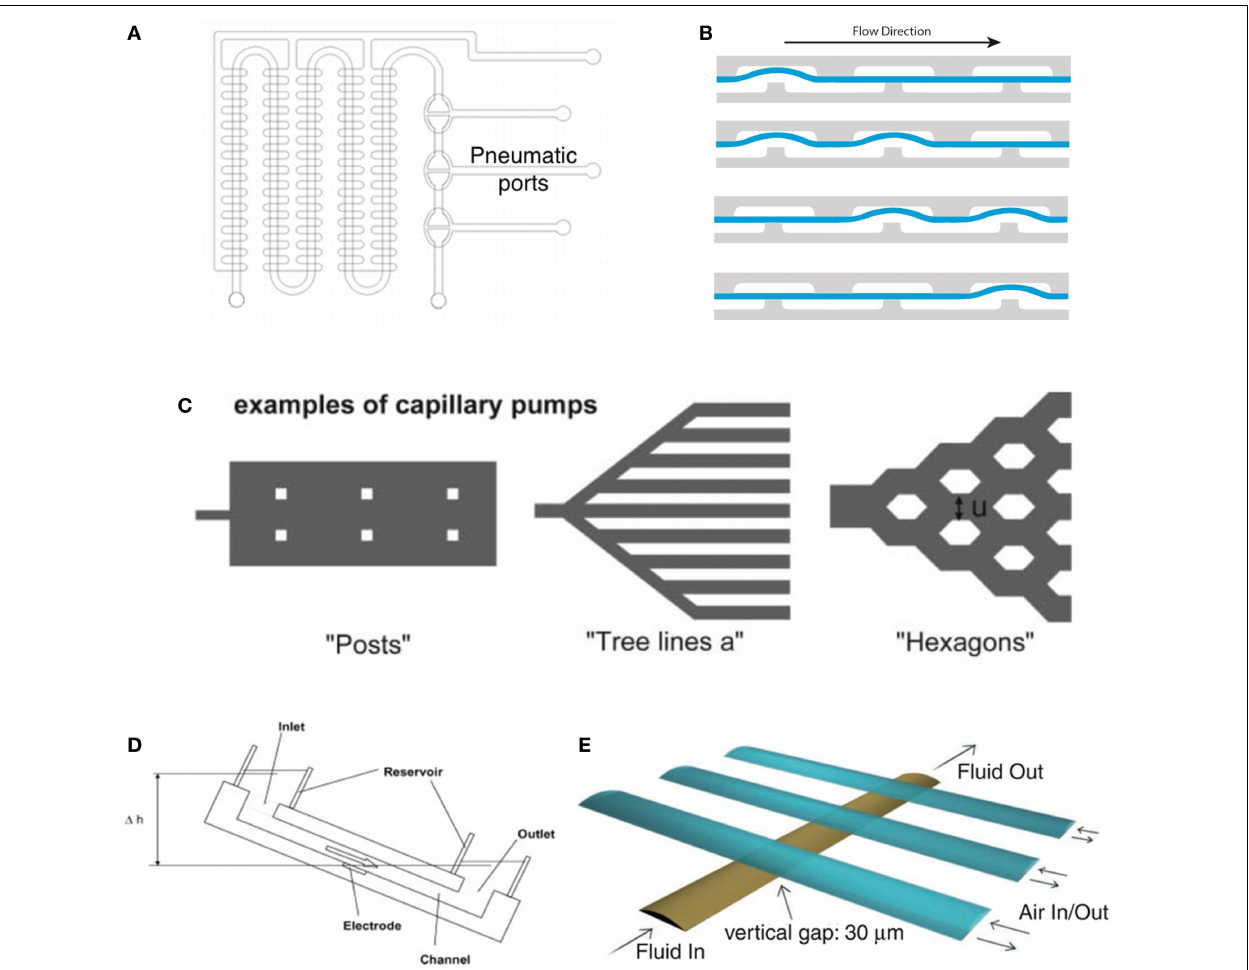
FIGURE 2 | Various types of micropumps for automated and nanoliter liquid handling . (A) Micropumps based on the pneumatic actuation principle developed by Grover et al. (2003) allowing the pneumatic actuation of the individual pumping chambers via a programmable controller. Reproduced by permission of by Elsevier (B) shows the schematics of the fluid transport in the micropumps based on the design introduced by Grover et al. (2003). Kindly provided by Novak (2013), (C) capillary pumps can be actuated by the different geometry and density of post as well as the relative positioning of the channels thus creating different capillary pressures. For detailed information, see (Zimmermann et al., 2007). Reproduced by permission of The Royal Society of Chemistry. (D) Schematic drawing of a gravitational-driven pump using the height difference Δ h between in- and outlet and thereby controlling the flowrate (Morier et al., 2004). Reprinted with permission of John Wiley & Sons, Inc. (E) Micropump design proposed by Unger et al. (2000) using a secondary gas-channel layer to control the flow-profile in the underlying liquid channel. Reprinted by permission of the American Association for the Advancement of